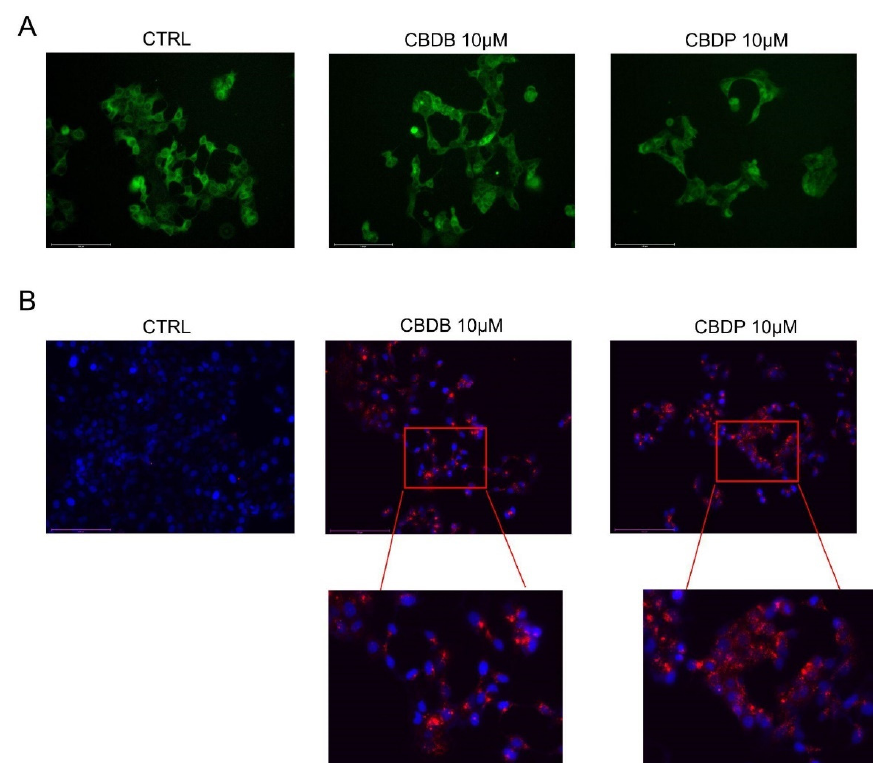
Figure 7. Representative fluorescent images of organelle structures. MCF-7 cells were treated with vehicle (DMSO) or CBDB and CBDP (10 µM) for 24 h. ( A ) Cells were stained with ER TrackerTM to visualize endoplasmic reticulum membranes. ( B ) Cells were stained with Hoechst (0.5 mg/mL) and Lysotracker Red DND-99 (100 nM) according to the manufacturer’s recommendations and imaged with an Evos m7000 fluorescence microscope. Scale bar 150 µm, objective 20×.